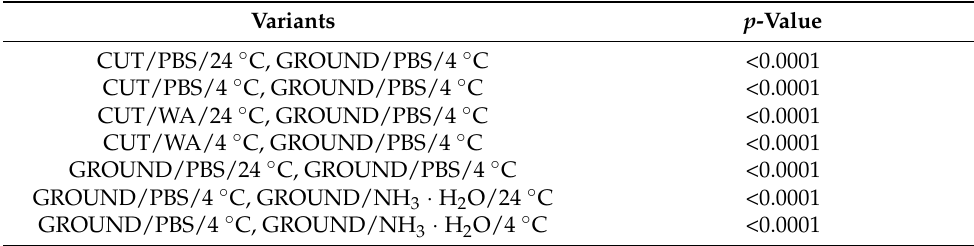
Figure 3. Percentage of proteins in the final decellularization product depending on the method of tissue disintegration (cut vs. ground), temperature (4 °C vs. 24 °C), and the solution used for rinsing (NH 3 · H 2 O vs. PBS). Table 1. p -values obtained for the results presented in Figure 3.